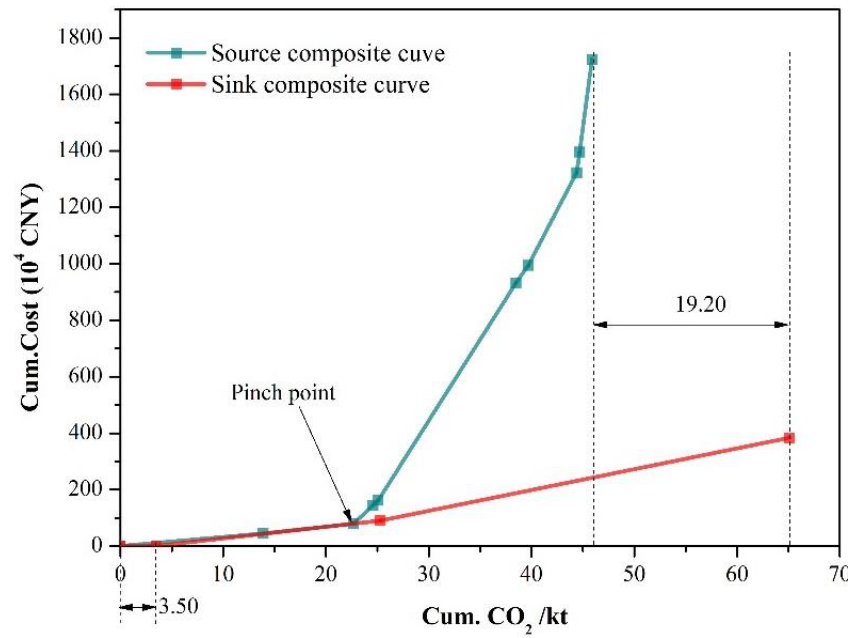
Figure 4. Optimized composite curve of the tobacco industry for Scenario 1.